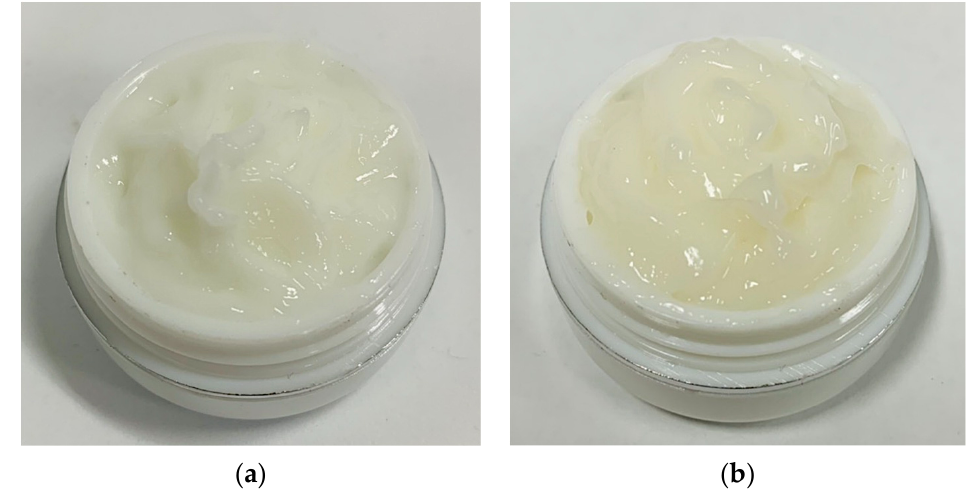
Figure 7. Cosmetic cream containing FA ( a ) and encapsulated FA ( b ).